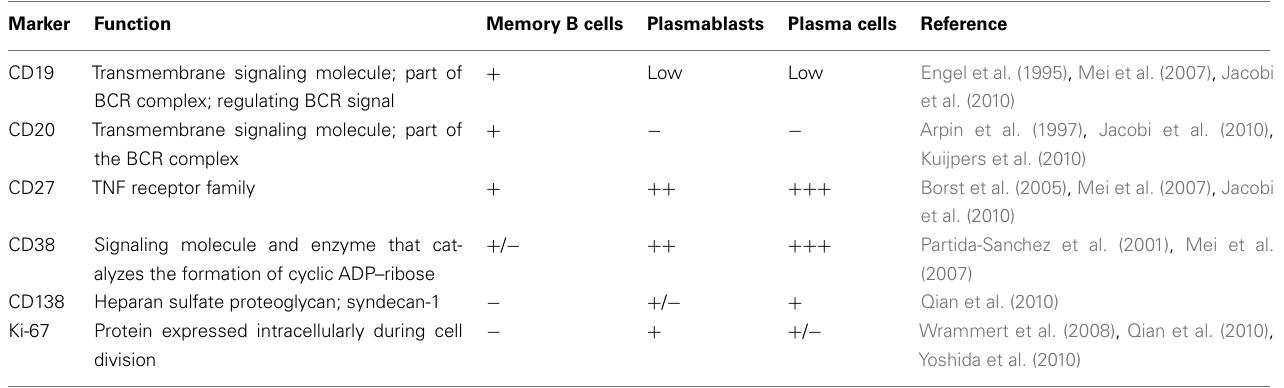
Table 1 | Markers of infection-induced plasmablasts and plasma cells in human blood. Marker